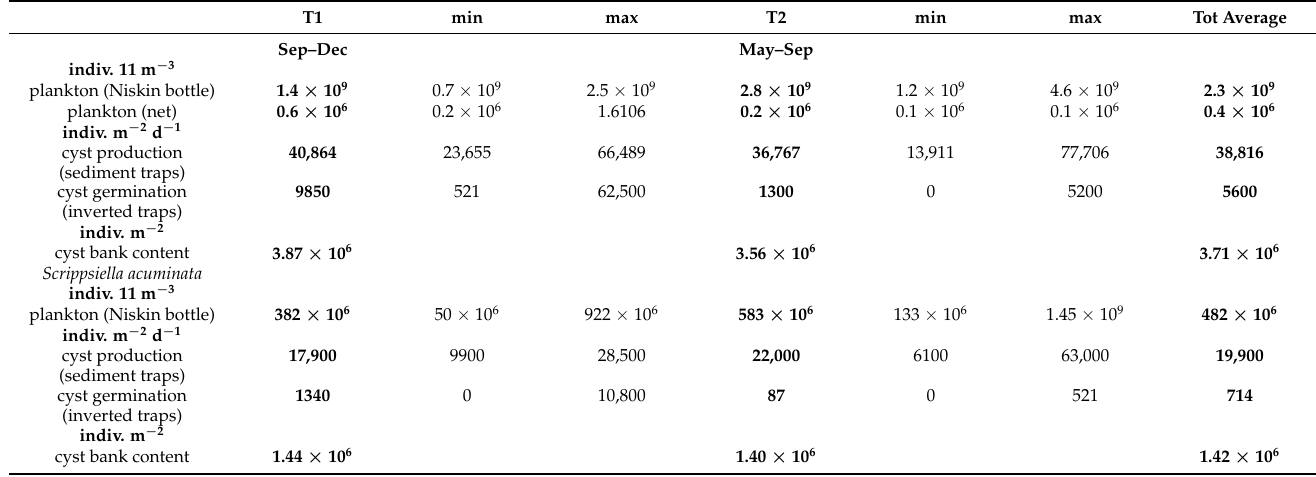
Table 4. Quantification of benthic-pelagic exchanges in terms of individuals in the Mar Piccolo of Taranto (2010–11). The unit of measurement of the plankton assemblages (indiv. 11 m − 3 of water) has been referred to the whole water column over the mouth of the sediment traps. The fluxes of cysts toward the bottom and of germinated specimens toward the water column, are indicated as indiv. m − 2 d − 1 . The cyst bank content (indiv. m − 2 ) refers to a sediment layer of 1 cm. All the values in bold are averages of the period (T1 and T2), with indication of minimum and maximum values. Scrippsiella acuminata has been chosen as a single species case. T1, T2, periods of sample